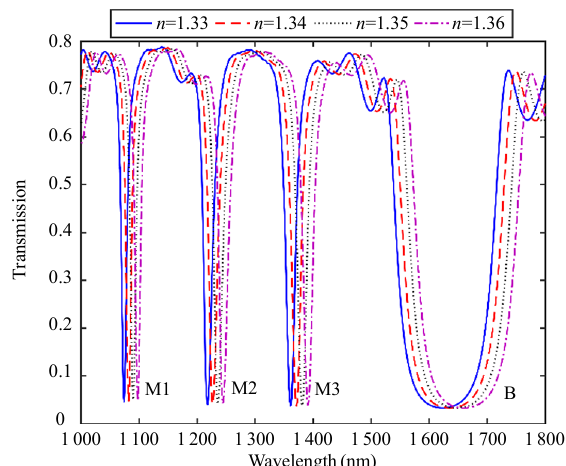
Fig. 9 Transmission spectra with RI of 1.33, 1.34, 1.35, and 1.36, respectively. Table 1 λ , Q , S , DL, and FOM of the dips by defining n =1.33, 1.34, 1.35, and 1.36,